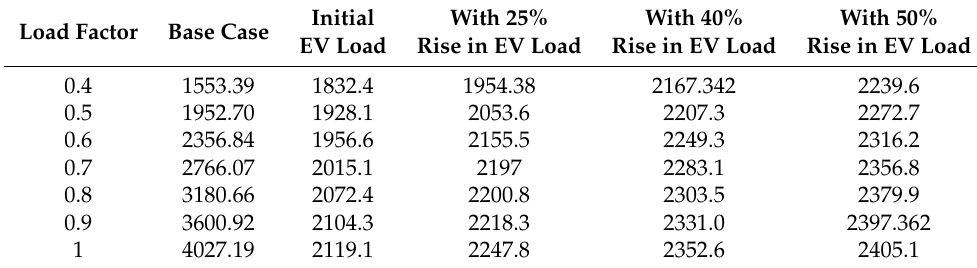
Table 14. Impact on the active power (kW) consumed from SS in the 69-bus radial